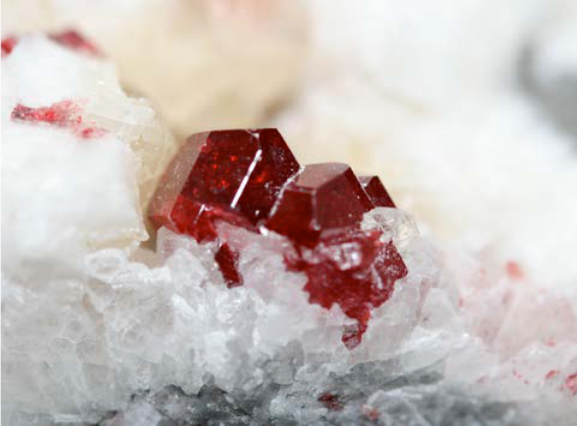
Figure 7. Cinnabar crystals in association with carbonates from Hunan Province, China. Photograph by Ruth Siddall.